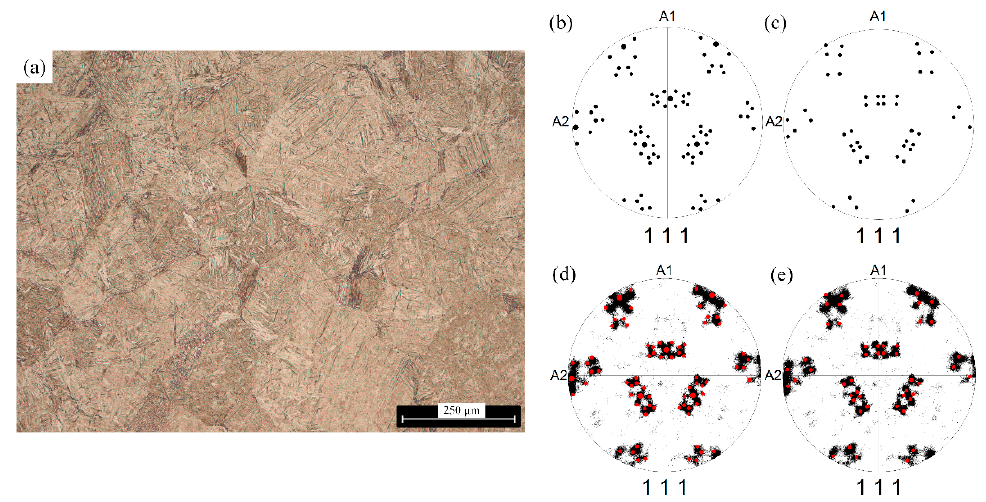
Figure 3. ( a ) Martensite microstructure after heat treatment; ideal {111} pole figure determined according to ( b ) Kurdjumov–Sachs (K–S) orientation relationship and ( c ) Nishiyama–Wassermann (N–W) orientation relationship; measured {111} pole figure superimposed with the ( d ) ideal K–S orientation relationship and ( e ) the ideal N–W orientation relationship.